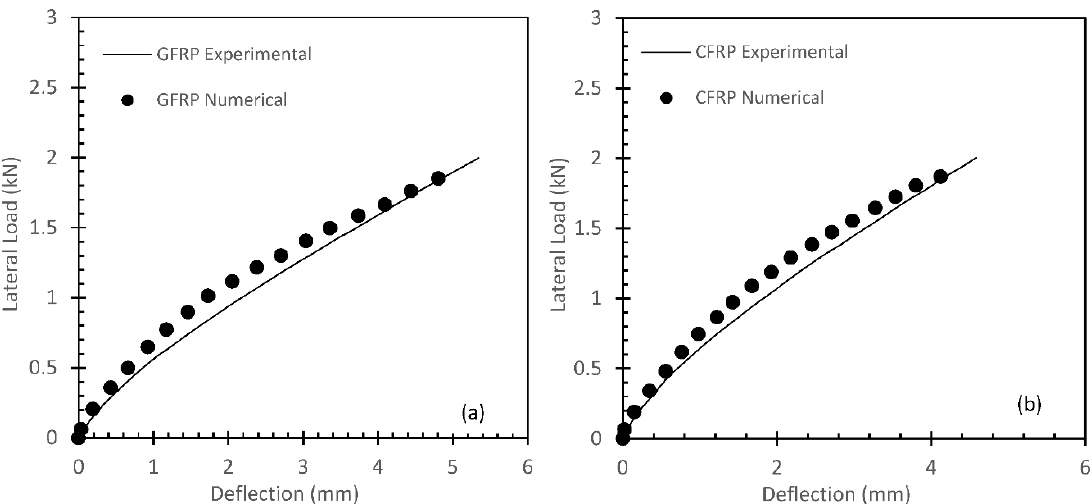
Figure 17. Validation of the axial load for the numerical and experimental results for GFRP ( a ) and CFRP ( b ).